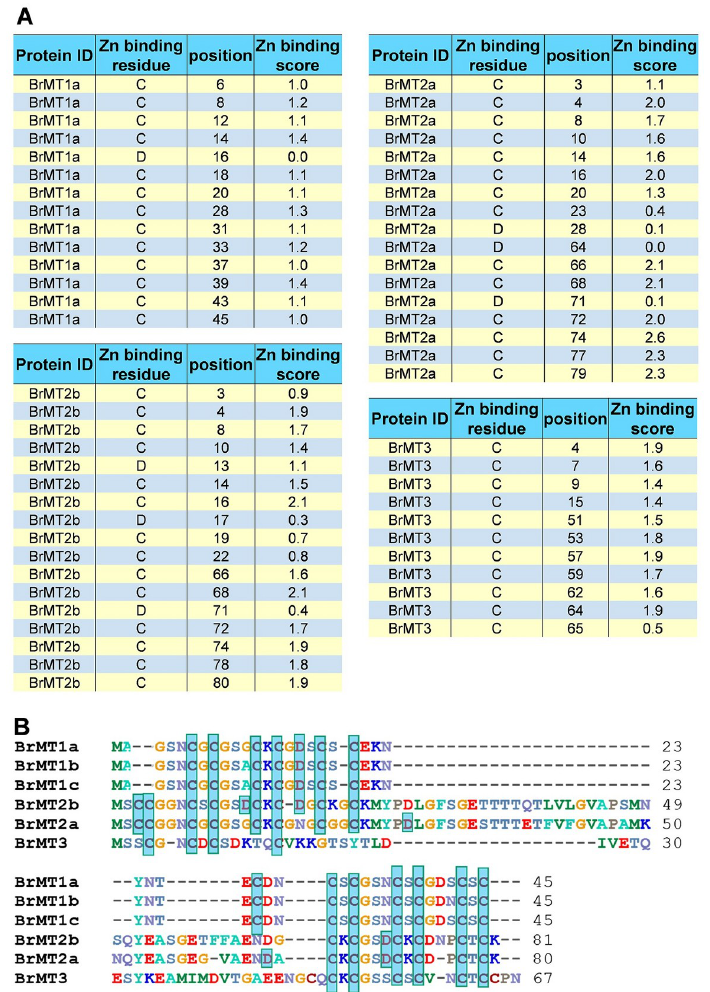
Fig 6. Analysis of Zn binding amino acid residues in B . rapa MTs. Zn binding amino acid residues of BrMT1a, BrMT2a, BrMT2b and BrMT3 were identified through the ZincBinder (http://proteininformatics.org/mkumar/ znbinder/), and alignment of BrMTs was performed using CLUSTALW program of BioEdit. (A) Zn binding amino acid positions and Zn binding scores of BrMT1a, BrMT2a, BrMT2b and BrMT3. (B) Alignment of BrMT1a, BrMT2a, BrMT2b and BrMT3 protein. Boxes indicate putative Zn binding amino acid